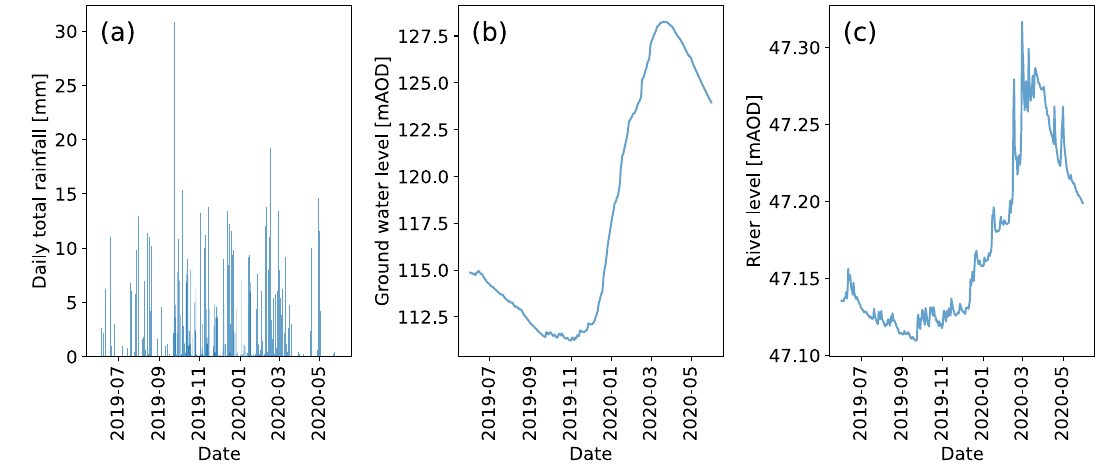
Figure 1. Times series graphs of ( a ) Daily total rainfall (Chenies, EA station); ( b ) Groundwater level (Ashley Green, EA station); and ( c ) River level of River Chess at Rickmansworth from 1st June 2019 to 1st June 2020 (EA Gauging station) 46 .